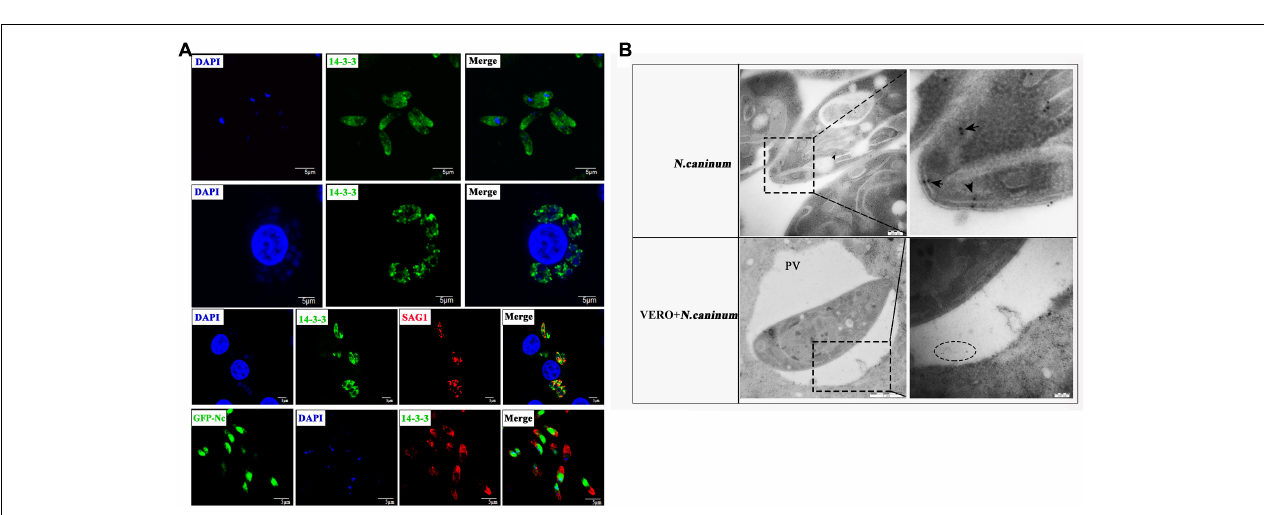
FIGURE 2 | Immunofluorescence (A) and immunogold (B) studies of 14-3-3 protein localization. (A) Immunofluorescence microscopy of N. caninum tachyzoites or VERO cells infected with N. caninum . Scale bars: 5 µ m. (B) Immunogold labeling of VERO cells infected with N. caninum tachyzoites. arrow: the gold particles within the tachyzoites, circle: the gold particles within the perivacuolar space. PV, parasitophorous vacuole.